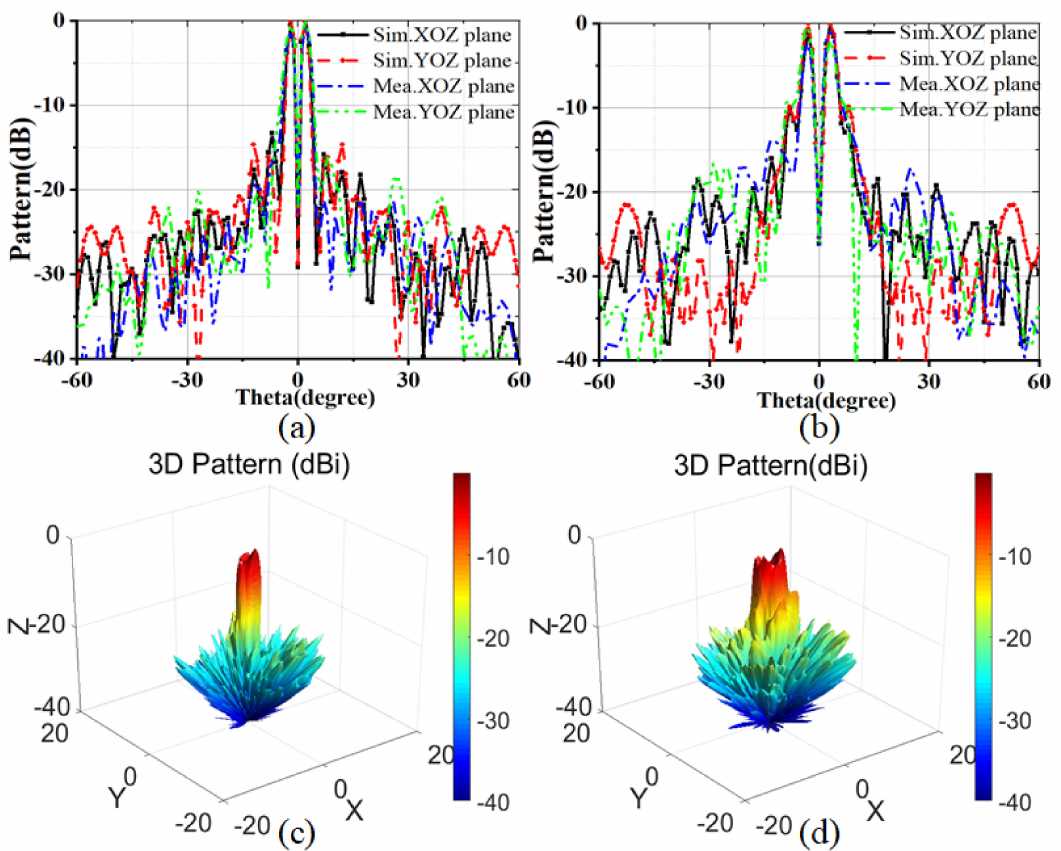
Figure 6. Far-field radiation patterns of OAM: ( a ) simulated and measured 2D patterns of l = 1; ( b ) simulated and measured 2D patterns of l = 2; ( c ) measured 3D pattern of l = 1; ( d ) measured 3D pattern of l = 2.